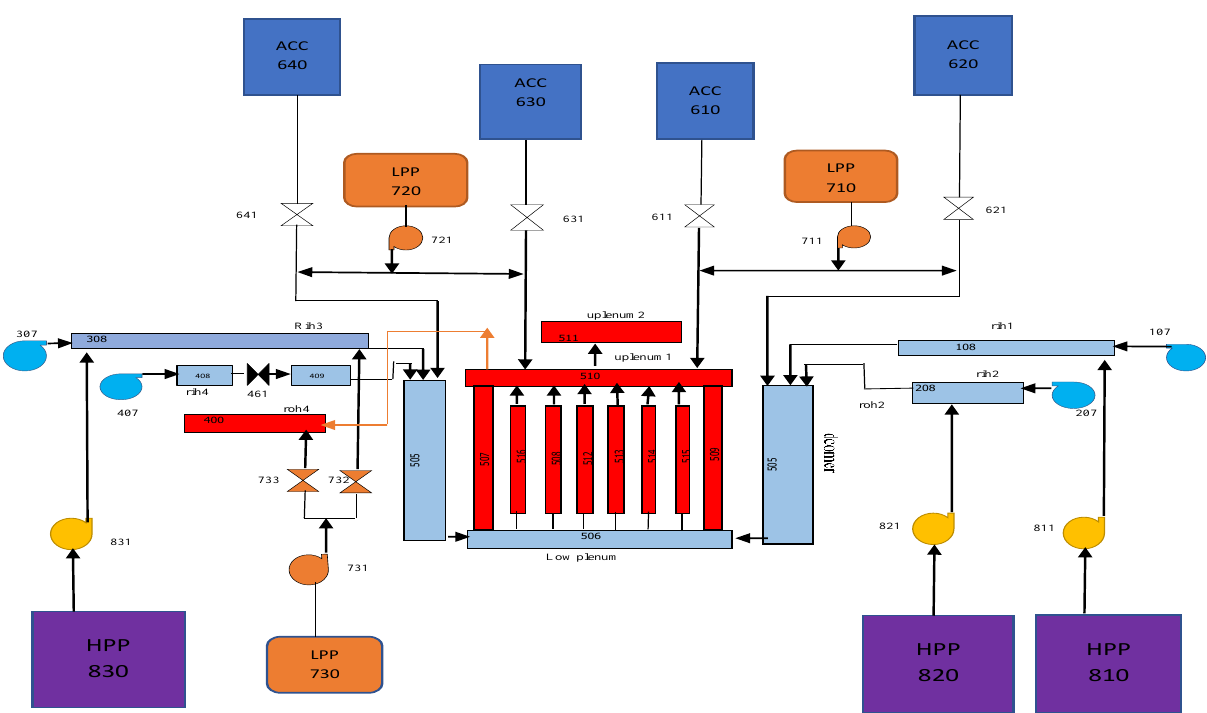
Figure 2. VVER-1000 nodalization of safety systems.